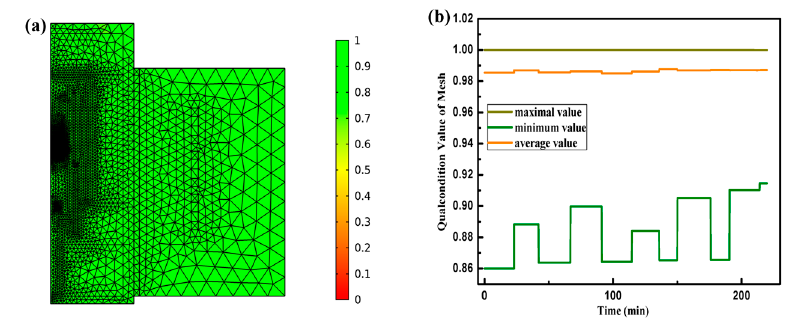
Figure 2. Mesh quality: ( a ) the initial mesh quality; ( b ) qual-condition value of the mesh.